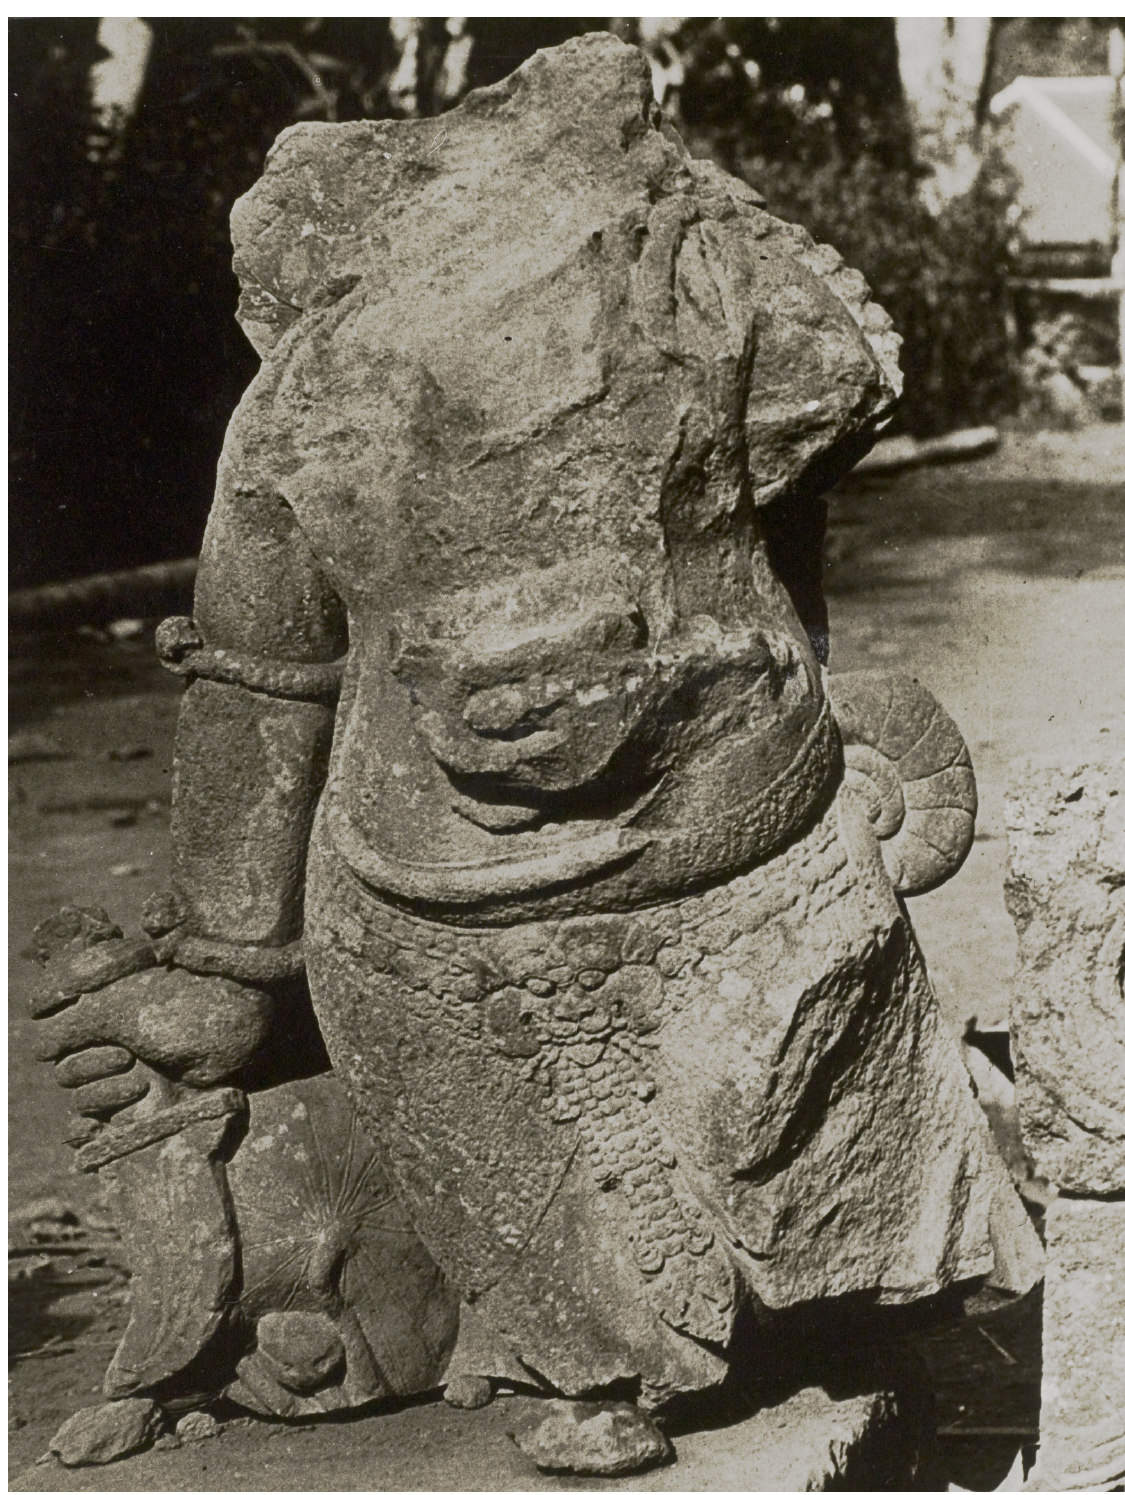
Figure 5 Vajramahākāla of Candi Jago, Malang, Eastern Java (detail). Siṅhasāri period, circa 1270s– 1292. Licence: CC BY 4.0. Source: Leiden University shelfmark KITLV